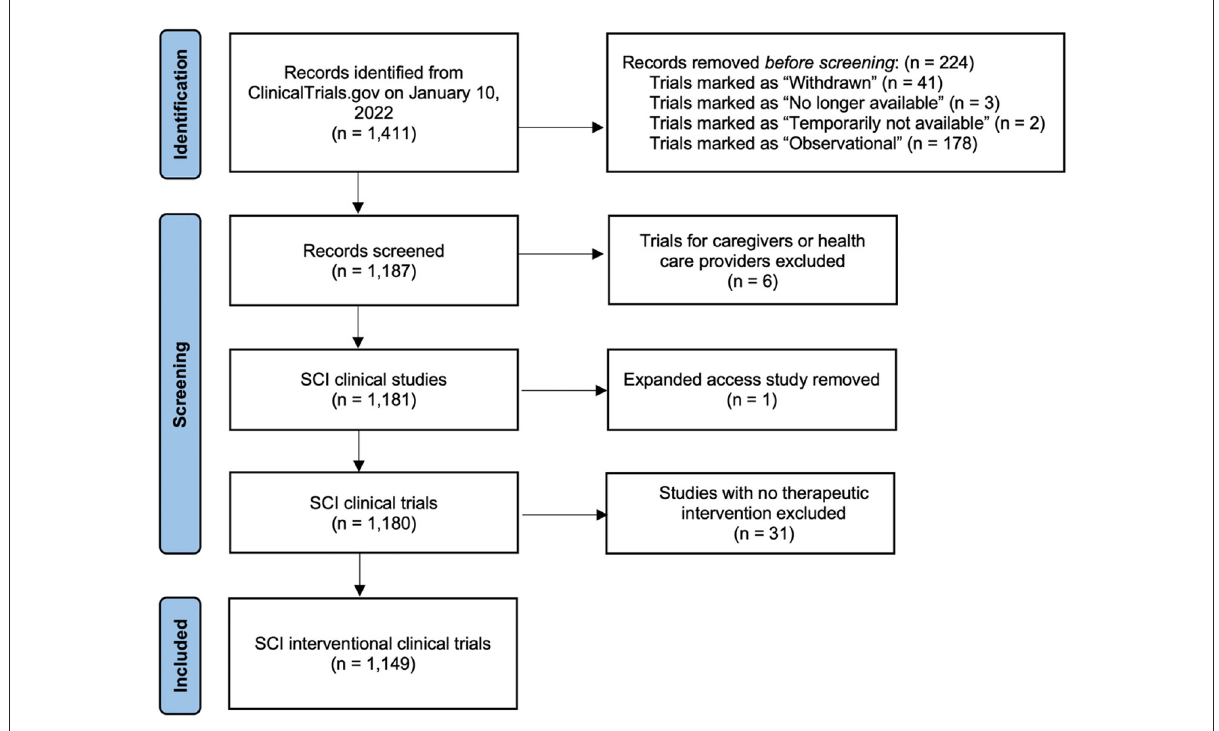
FIGURE1 PRISMA flow diagram of the search strategy used in this study. SCI, spinal cord injury (Page et al.,